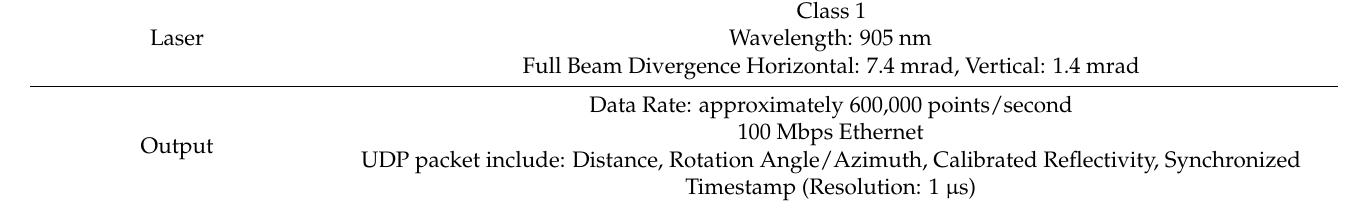
Table 2. Technical Specifications of RS-LiDAR-32 (from product manual).